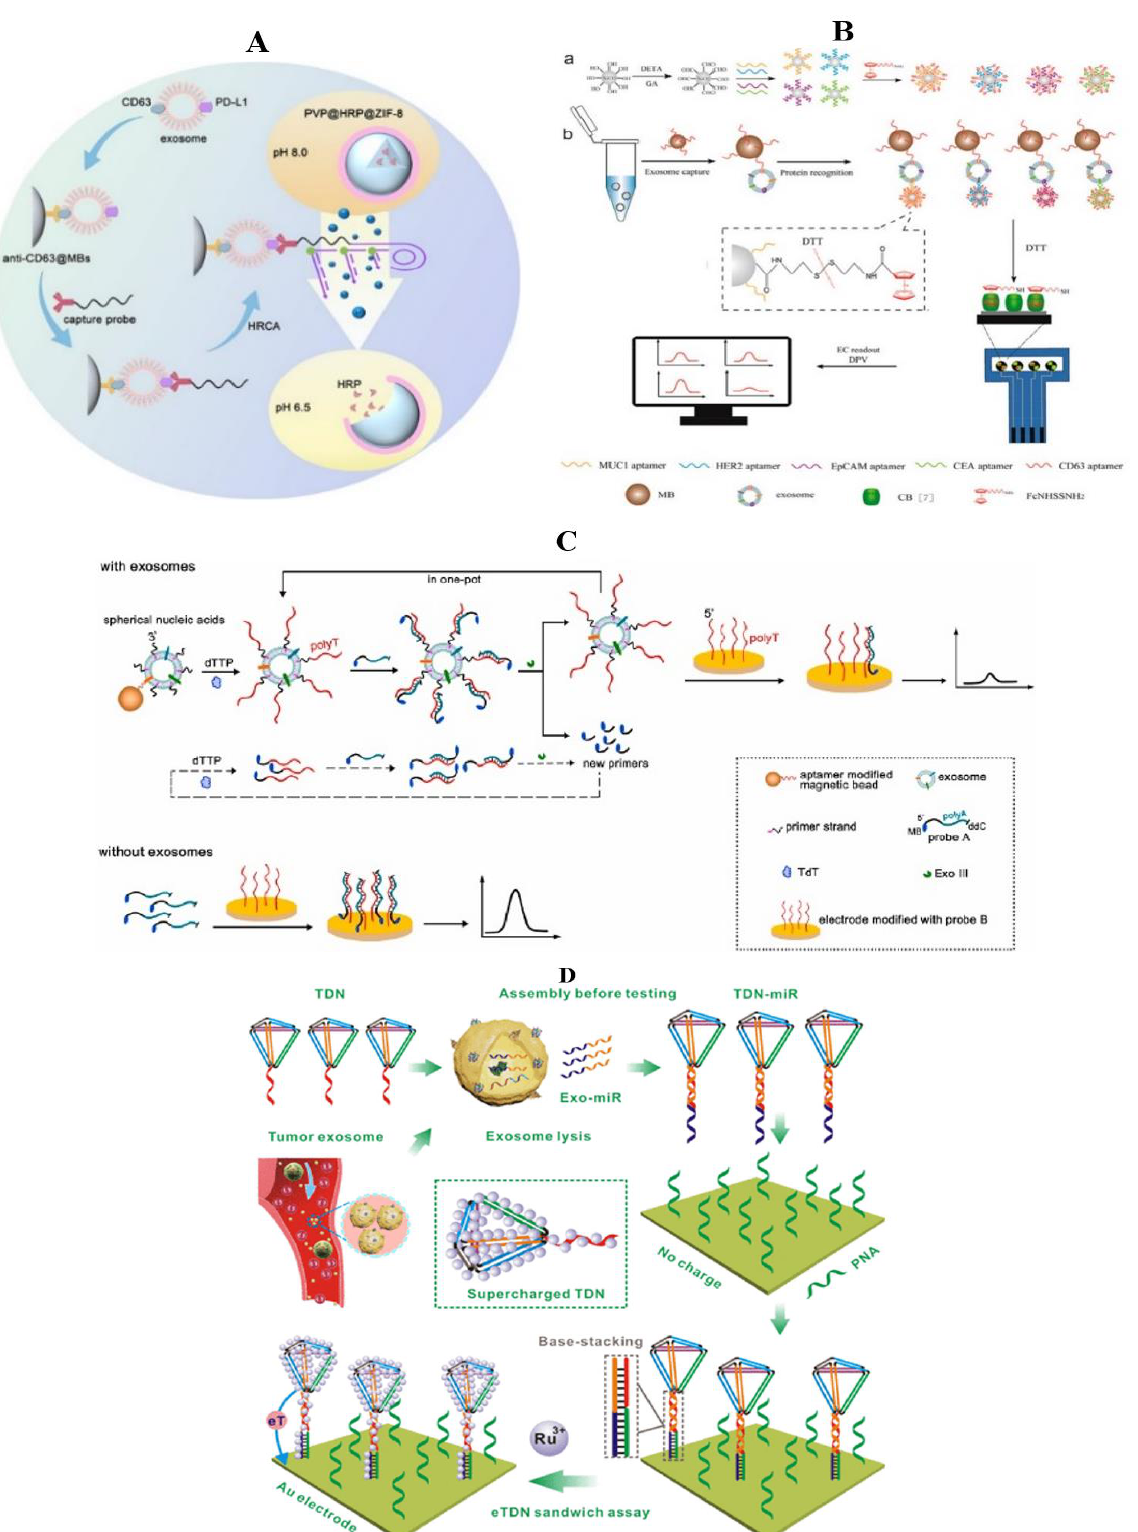
Figure 9. Detection of exosomes in breast cancer by the electrochemical method (nanomate- rial). ( A ) Schematic illustration of identification of PD-L1+ exosomes based on HRCA-responsive PVP@HRP@ZIF-8 [152]; ( B ) schematic representation of the magneto-mediated electrochemical sen- sor for exosomal proteins analysis based on host–guest recognition [154]; ( C ) the principle of the biosensor based on design of spherical nucleic acids and enzyme-mediated triple signal